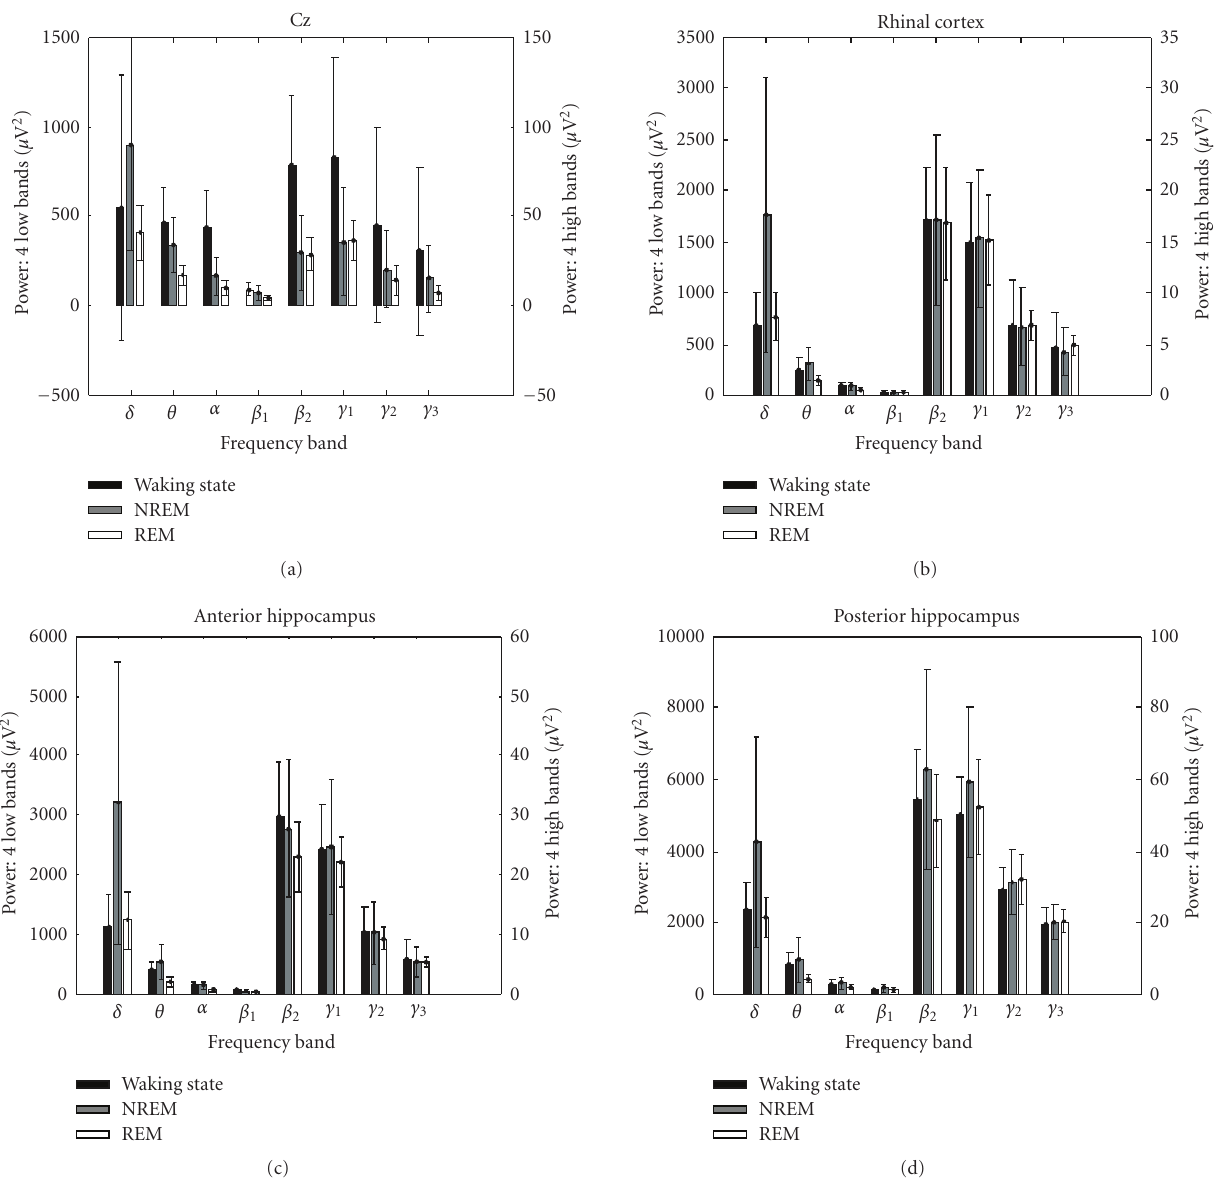
Figure 3: Power values (mean and standard deviation across epochs) in scalp EEG and medial temporal locations. Please note that to improve visibility of e ff ect of sleep stage, ordinate scaling di ff ers for low- ( δ to β 1 ) and high- ( β 2 to γ 3 ) frequency bands. In contrast to the e ff ect of sleep on power correlations (see Figure 2), power values in the high-frequency band were maximal during waking state.